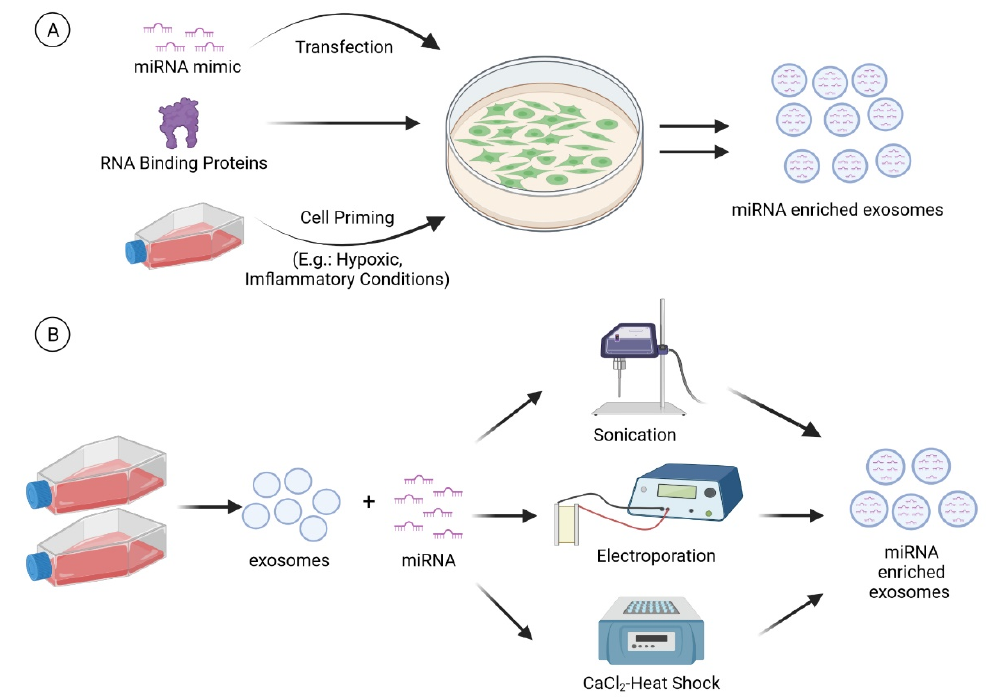
Figure 3. miRNA enrichment can be performed via ( A ) cell modification or ( B ) direct loading of miRNAs into exosomes. For cell modification, a miRNA mimic is transfected into the cells. In addition, RNA binding proteins and cell priming (e.g., hypoxia and inflammatory cytokines) strategies can also be employed to modulate the miRNA cargo of exosomes. Techniques such as sonication, electroporation, and CaCl 2 -heat shock can be used to load the miRNAs directly into the exosomes. (Created with BioRender.com on 28 July 2021).